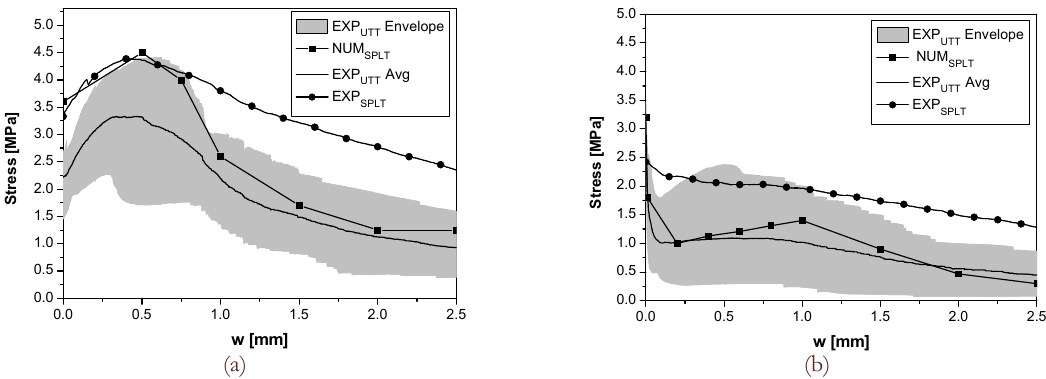
Figure 14: Comparison of the uniaxial stress – crack width relationship, σ – w , for: (a) θ = 0 ° and (b) θ = 90 °